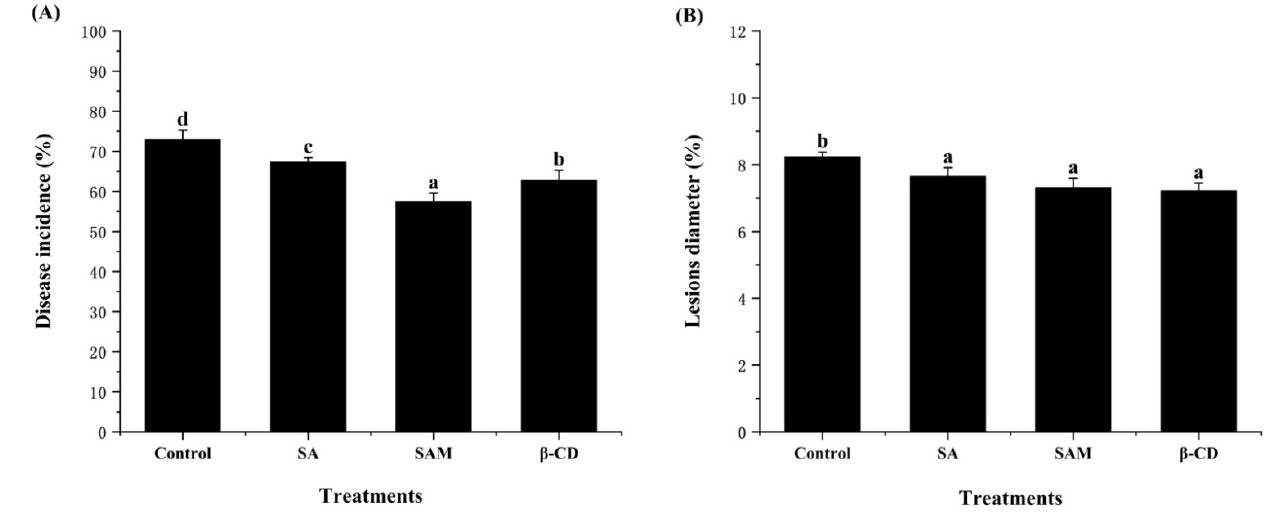
Figure 2. Effect of SAM on disease incidence ( A ) and lesion diameter ( B ) in ‘Fuji’ apple following Penicillium expansum infection after 5 days of storage at 25 °C. SA, salicylic acid; SAM, salicylic acid microcapsule; β -CD, β -cyclodextrin. Control group was prepared with sterile distilled water. Vertical bars represent standard errors. Different letters show a significant difference ( p < 0.05).